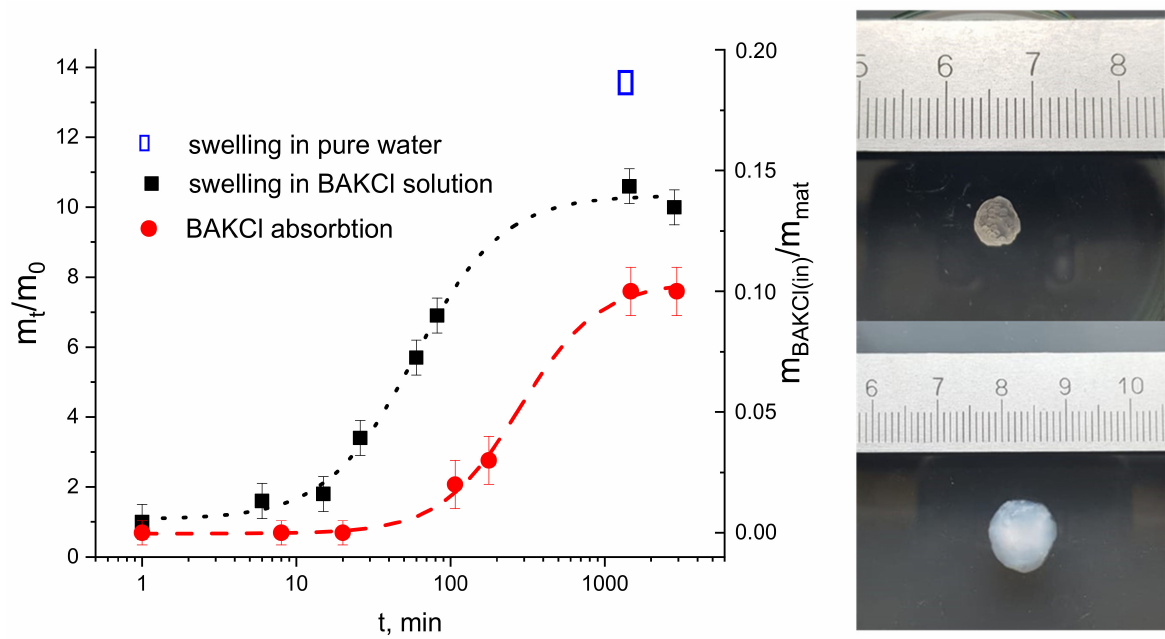
Figure 3. On the left —the kinetics of swelling (black dots and line) of the IPN material in aqueous BAKCl solution, represented as a mass of the sample m at the moment t divided by the mass of the sample at t = 0 (corresponds to the mass of dry material) versus time. The kinetics of BAKCl absorption (red dots and line) by IPN material, represented as a mass of the absorbed BAKCl m BAKCl ( in ) divided by mass of the sample m mat versus time. On the right —PNIPAAm-PAA IPN material (upper image) before and (lower image) after swelling in an aqueous BAKCl